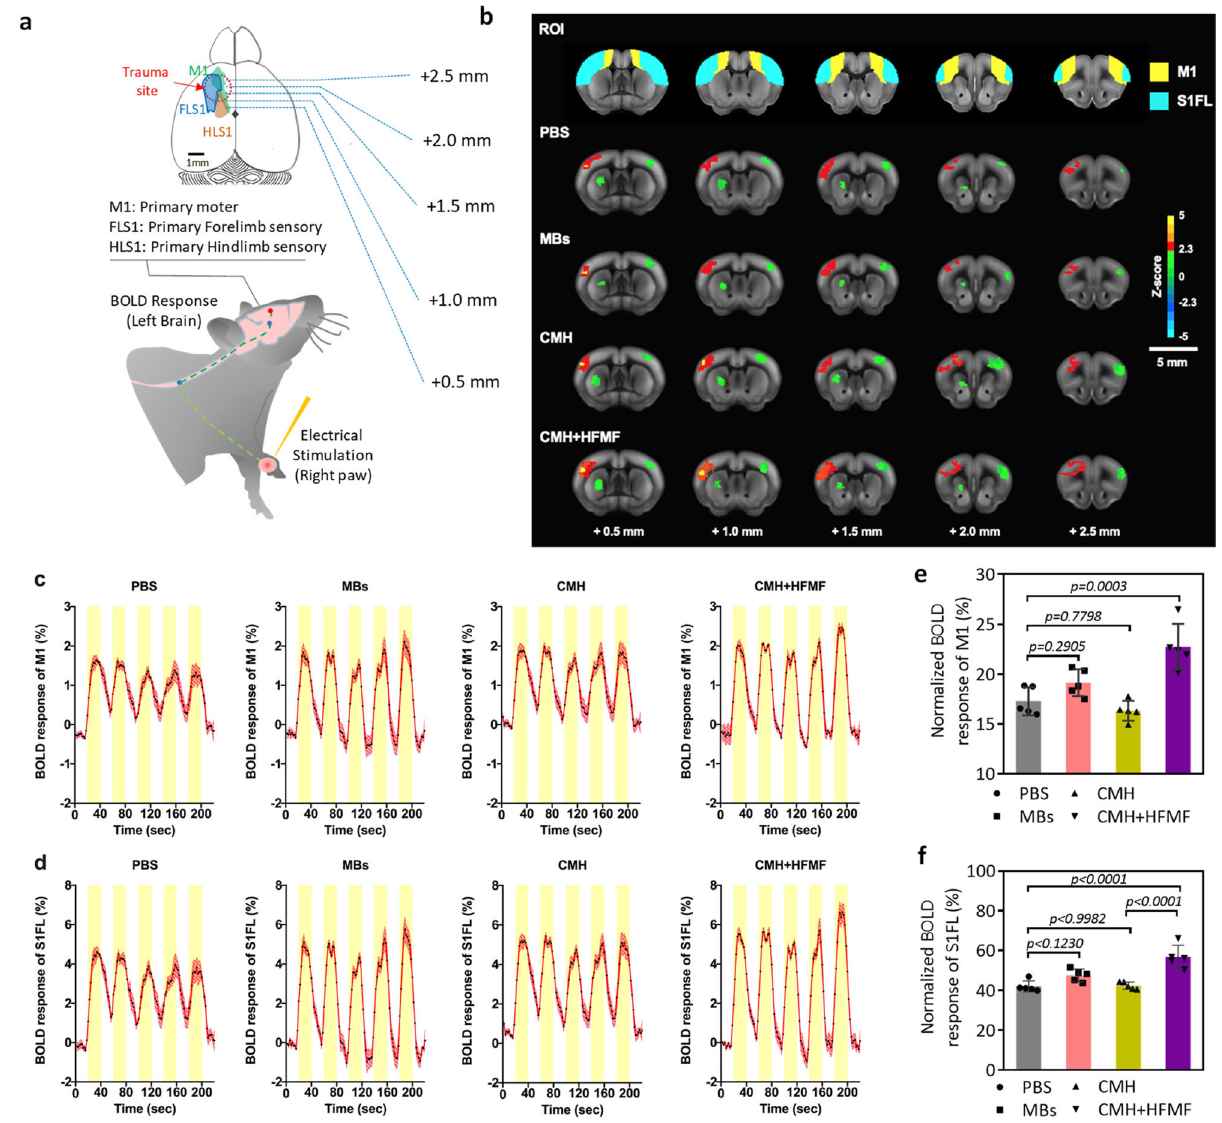
Fig. 7 | Blood-oxygenation level-dependent (BOLD) fMRI activation maps during contralateral forepaw stimulation. a Illustration of the experimental design. Activation was triggered by electrical stimulation of the right forepaw 30 days after TBI. b Comparison of activation Z-maps obtained by group-level BOLD contrasts in the treated groups of PBS ( n =6), MBs ( n =6), CMH ( n =6) and CMH+HFMF ( n =6), respectively, superimposed on corresponding high- resolution RARE T2 images. Visualization of activation Z-maps displayed at z- threshold free and their activity in voxels within the red boundary reached the